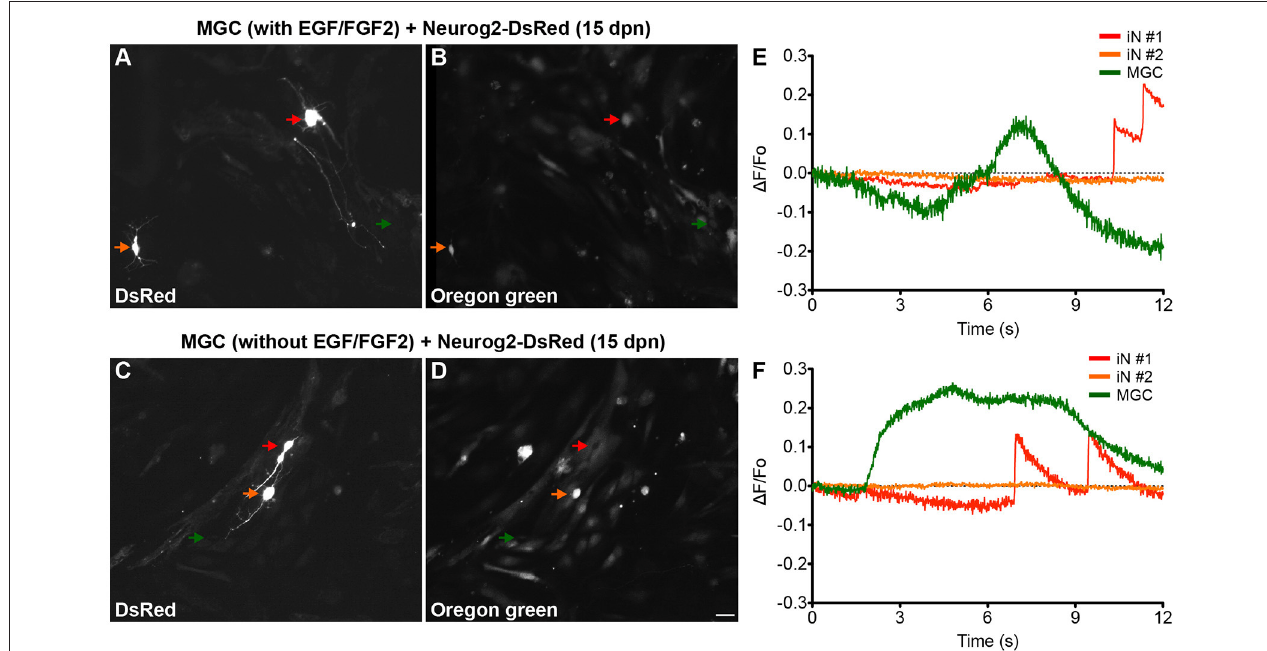
FIGURE 4 | MGC-derived iNs display fast calcium transients. (A–D) Photomicrographs show examples of MGC-derived iNs at 13 days dpn with Neurog2-I-DsRed expressing DsRed (A,C) , and labeled with Oregon Green Bapta (B,D) . Red and orange arrows point to DsRed + MGC-derived iNs, whereas green arrows point to non-transfected MGCs randomly selected within the same fields of observation. Top (A,B) and bottom (C,D) images were obtained from MGCs expanded in the presence of absence of EGF/FGF2, respectively. (E,F) Representative traces of calcium-transients in cells indicated by colored arrows in (A,E) and (C,F) . Calcium responses were calculated as the change in fluorescence ( 1 F) over the initial fluorescence (F 0 ). Note that only iNs indicated by the red arrows displayed fast calcium-transients as indicated by rapid variations in the fluorescence (raising interval between 10 – 30ms). In contrast, non-transfected MGCs (green arrows) have only slow calcium-transients as indicated by gradual changes in fluorescence levels (raising interval > 1s), suggestive of metabotropic responses. DsRed + cells indicated by the orange arrows did not show any significant fluctuation in fluorescence levels during the period of observation. Scale bar: 20 µ